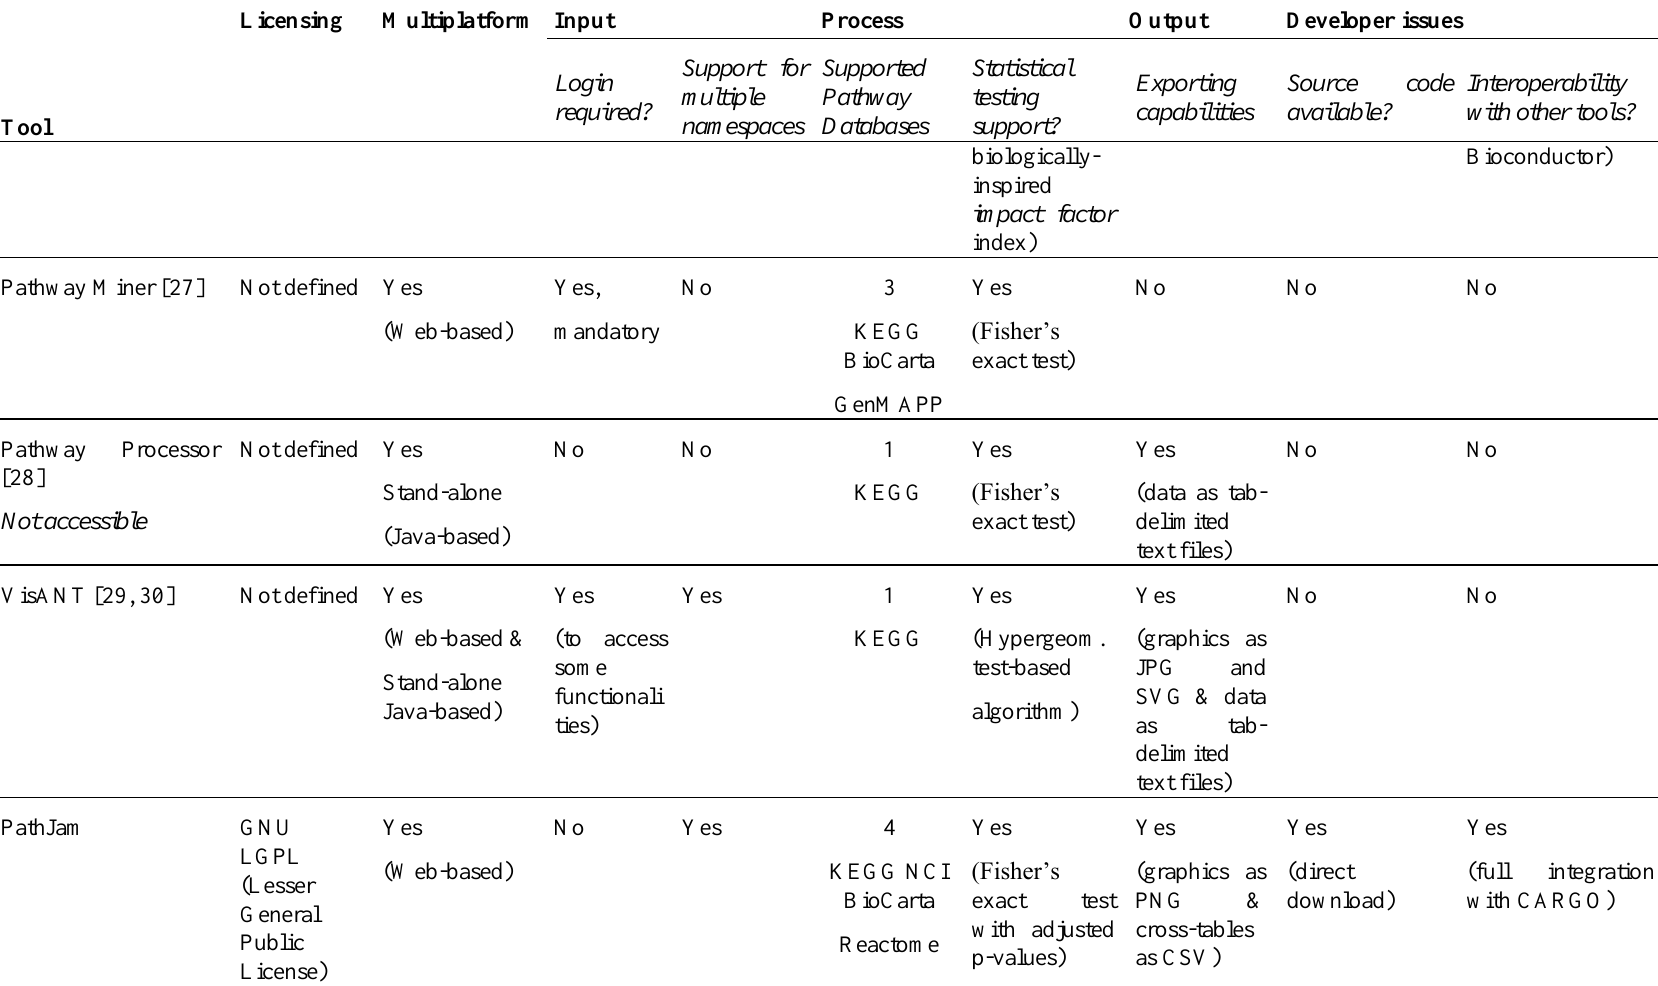
Table 1: Comparison of PathJam with existing